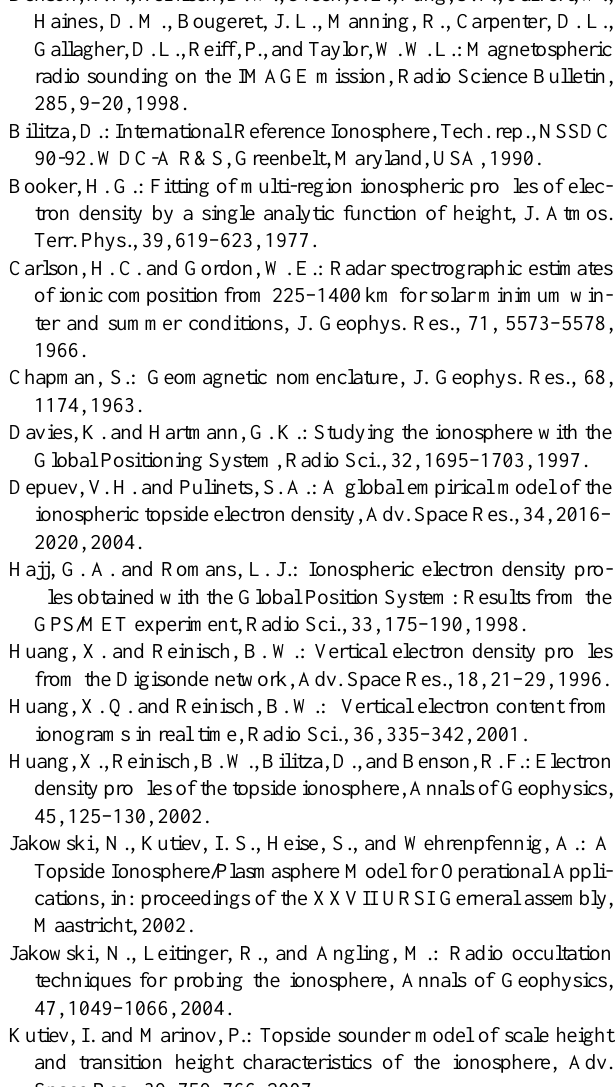
Fig. 5. Profiles of the O + and H + densities plotted together with the resulting N e